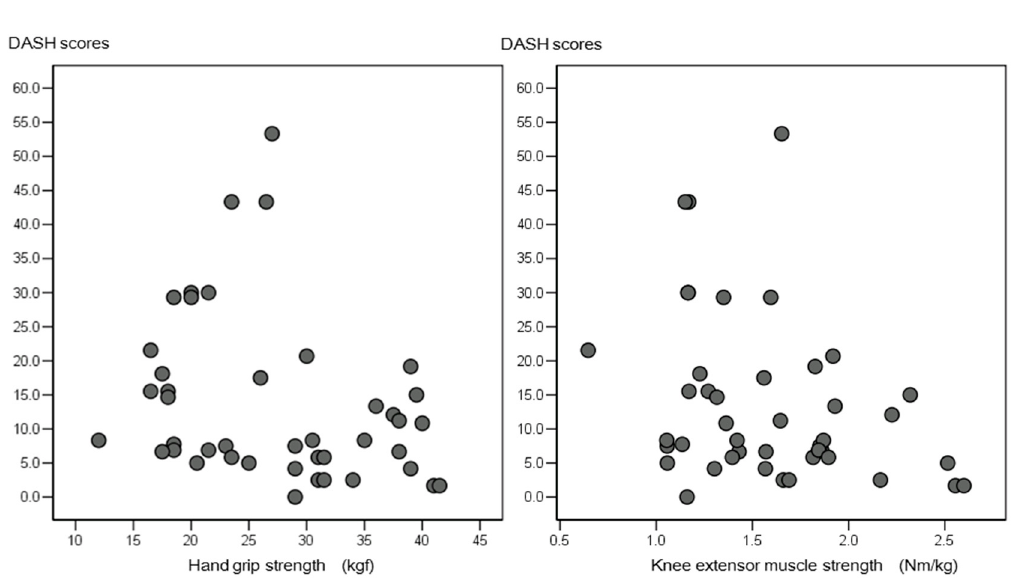
Figure 2. Relationship between handgrip strength, knee extensor muscle strength, and DASH scores of the patients. DASH, Disabilities of the Arm, Shoulder, and Hand.